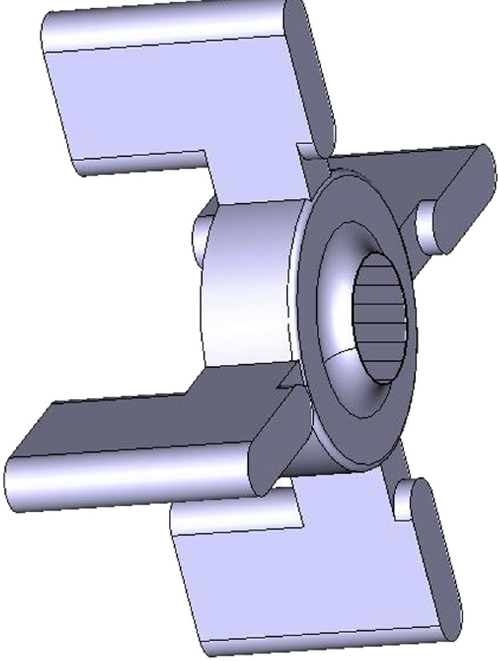
FIG. 8. (Color) Wake monitor cell using side coupled output waveguides with electric short on one side.